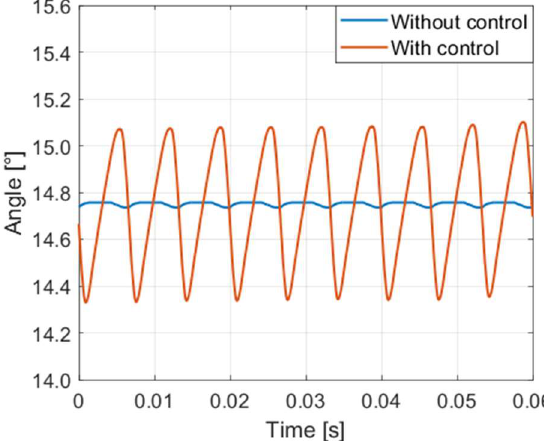
Figure 14. Swash plate position. Shaft speed 1000 r/min.